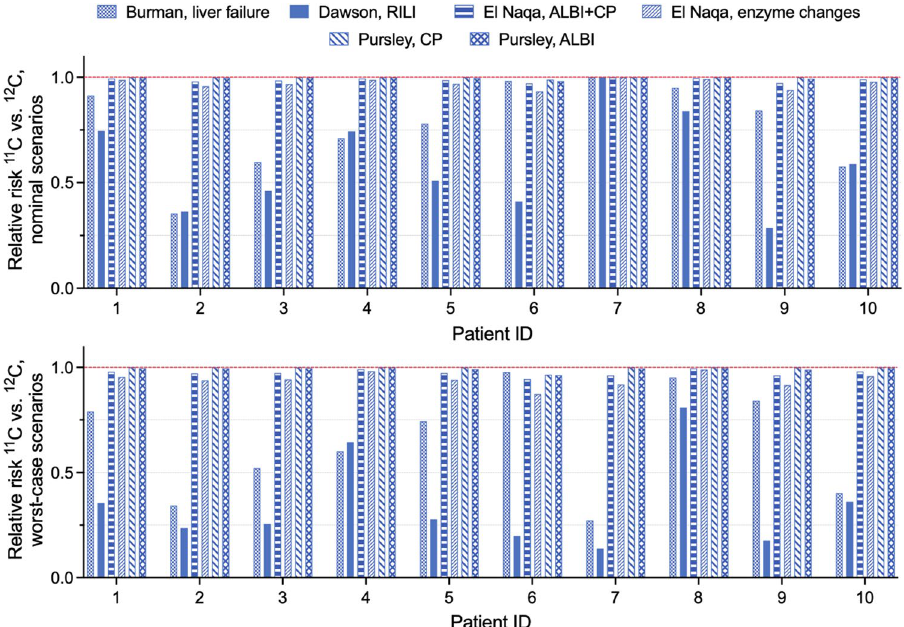
Figure 6. Relative risks representing the ratio of 11 C versus 12 C NTCP values for individual liver patients